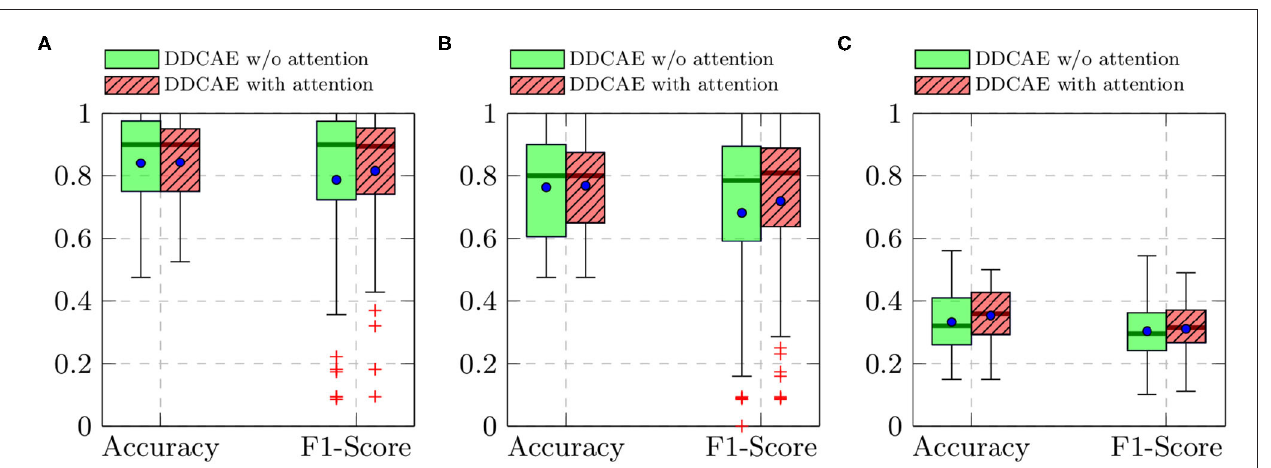
of the proposed architecture. In the case of the multi-class classification task ( T 0 vs . T 1 vs . T 2 vs . T 3 ), the improvement of